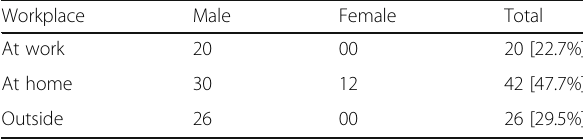
Table 4 Distribution of cases according to place of occurrence